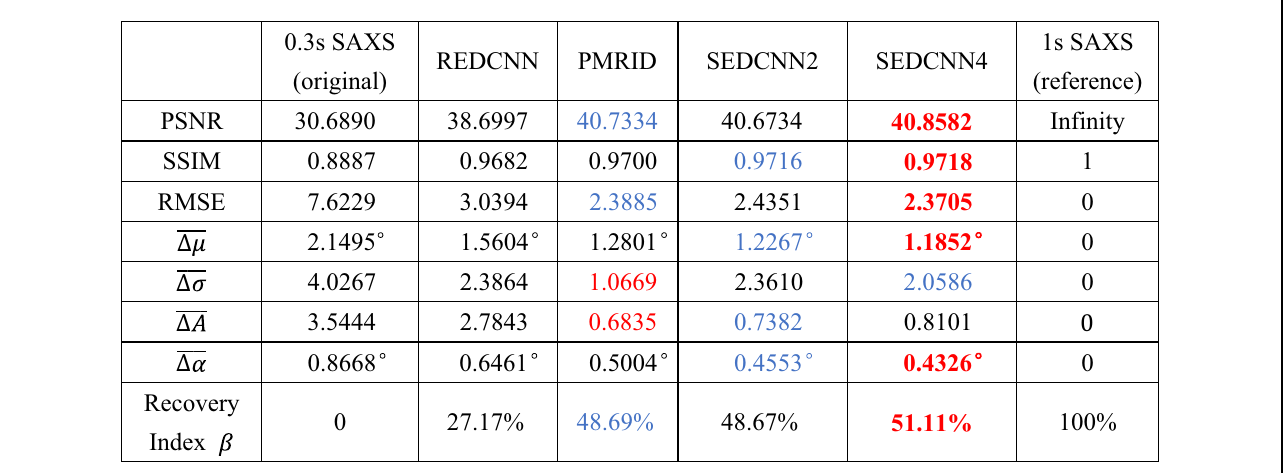
We calculated Δ α , Δ μ , Δ σ , and Δ A for each image, along which a